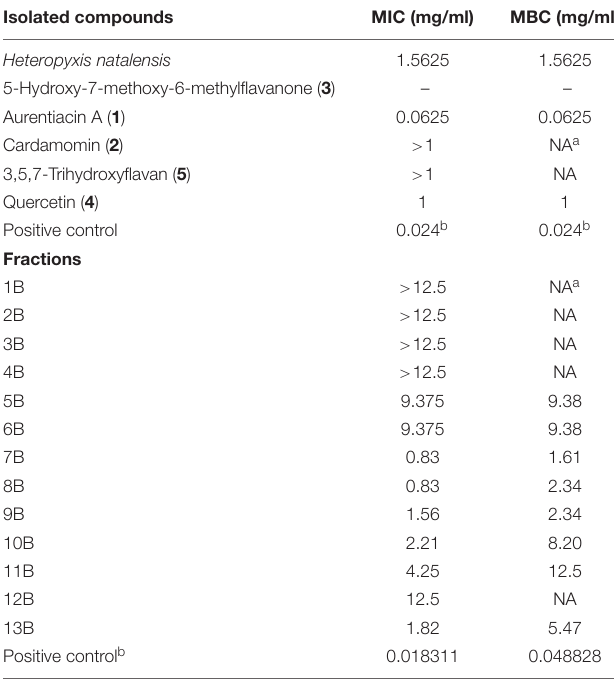
TABLE 2 | The minimum inhibitory concentration (MIC) and minimum bactericidal concentration (MBC) of the major fractions and isolated compounds from H. natalensis against Actinomyces israelii